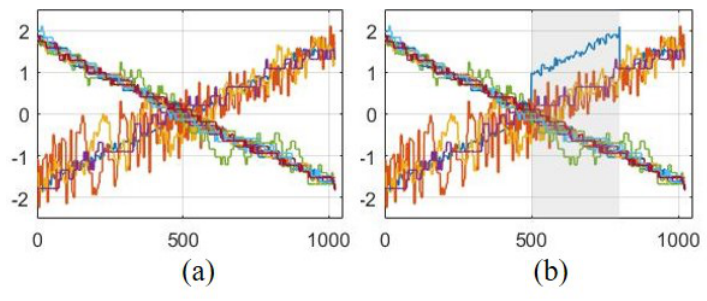
Figure 17. Packed bed pilot plant training ( a ) and testing ( b )